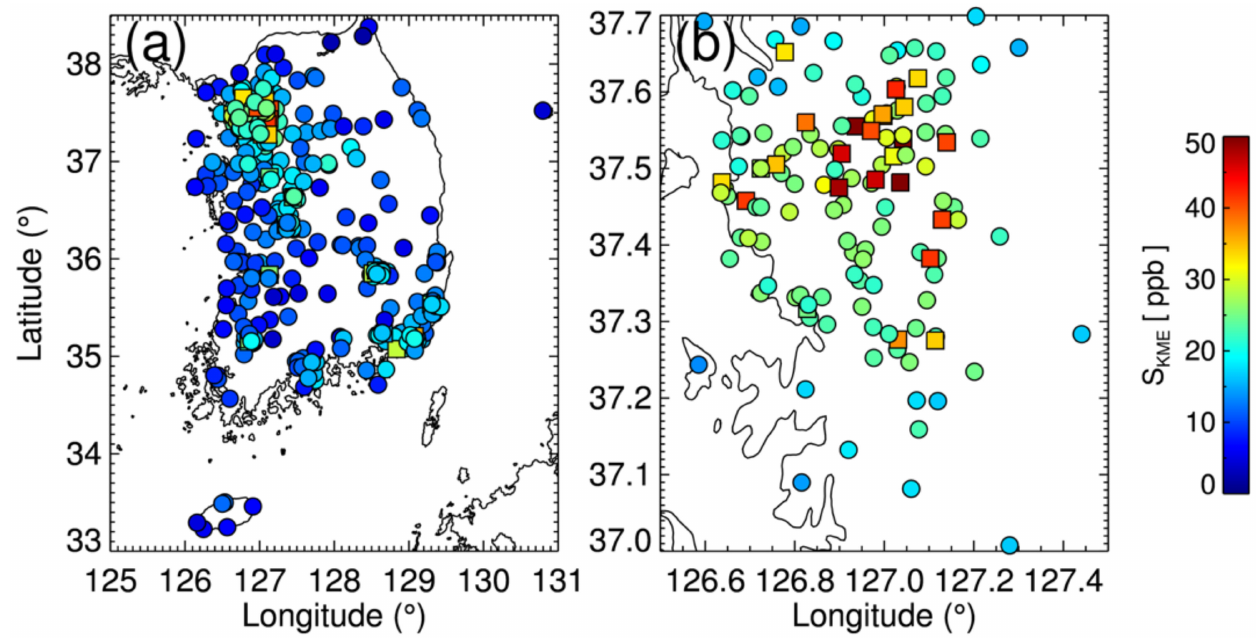
Figure 1. Average value of surface NO 2 mixing ratio for 2019 measured by ground air-quality monitoring network of Korea Ministry of Environment over ( a ) South Korea and ( b ) Seoul metropolitan area. Squares indicate air quality monitoring stations on the side of roads with heavy traffic, representing point sources and circles represent ambient air quality monitoring sites away from point